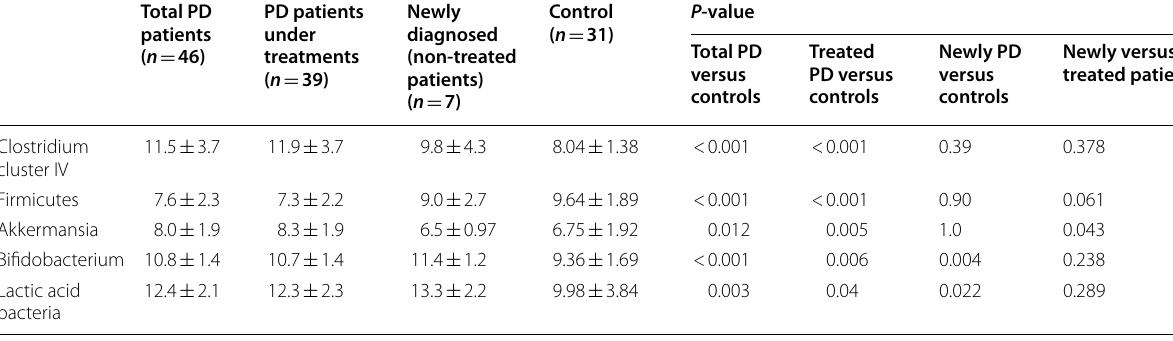
Table 2 Copy number of gut microbiota among Parkinson’s disease patients and control group